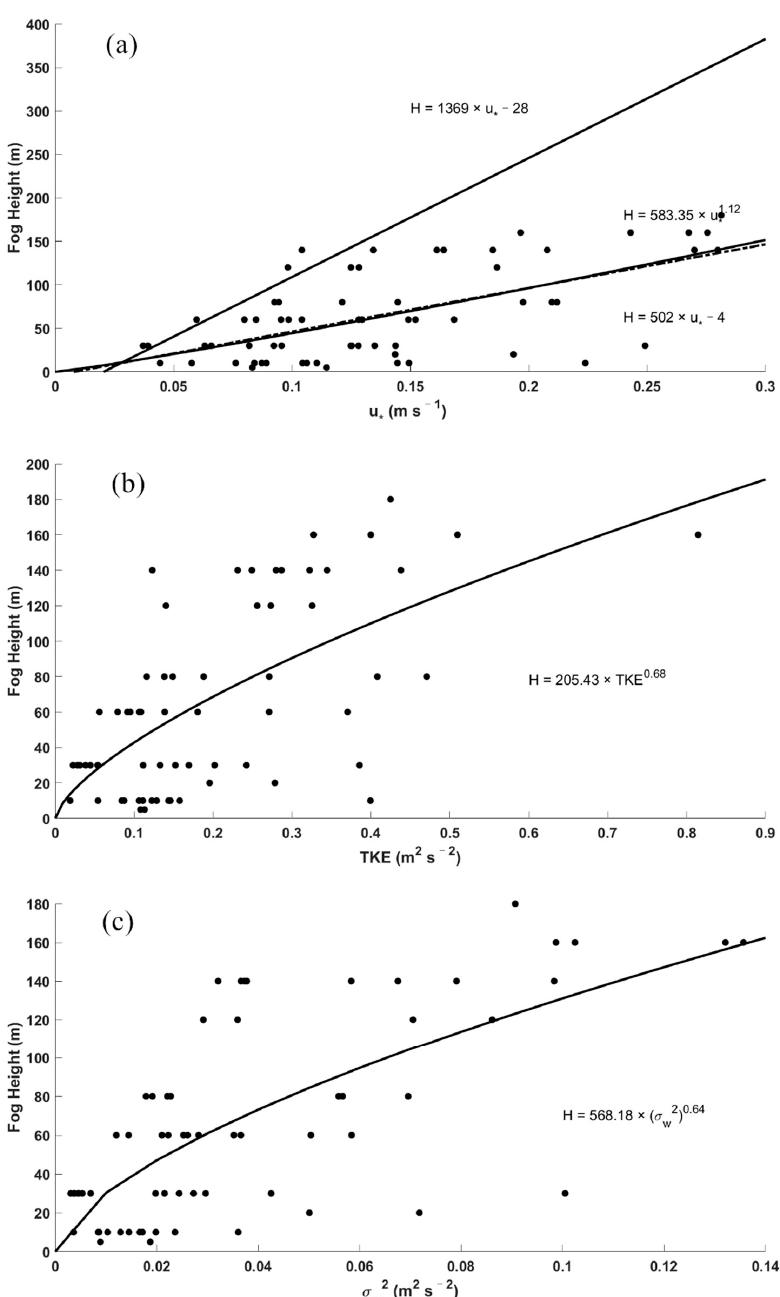
Figure 1. ( a ) Scatterplots of observations of fog-top height against the friction velocity. The bottom solid line denotes the relationship H = 583.35 × u *1.12 , the bottom dashed line denotes the relationship H = 502 × 𝑢 ∗ – 4, and the upper solid line denotes the relationship H = 1369 × 𝑢 ∗ – 28. ( b ) Scatterplots of observations of fog-top height against TKE . The solid line denotes the relationship H = 205.43 × (cid:4666) TKE (cid:4667) 0.68 . ( c ) Scatterplots of observations of fog-top height against the variance of vertical velocity ( σ w2 ). The solid line denotes the relationship H = 568.18 × (cid:3435) σ w2 (cid:3439) 0.64 .